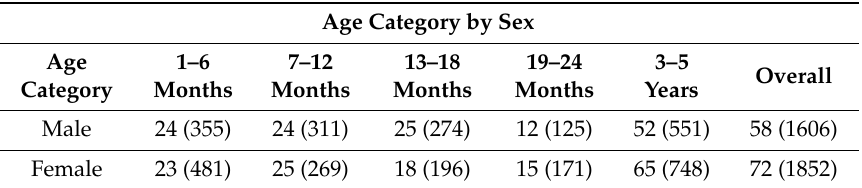
Table 3. Number of wild African calves sampled from 1982 to 1984, by sex and age category. Parenthesis = total number of 60 min continuous focal samples by age–sex class. Total N calves = 129, median N focals per calf = 2, min = 1, max =